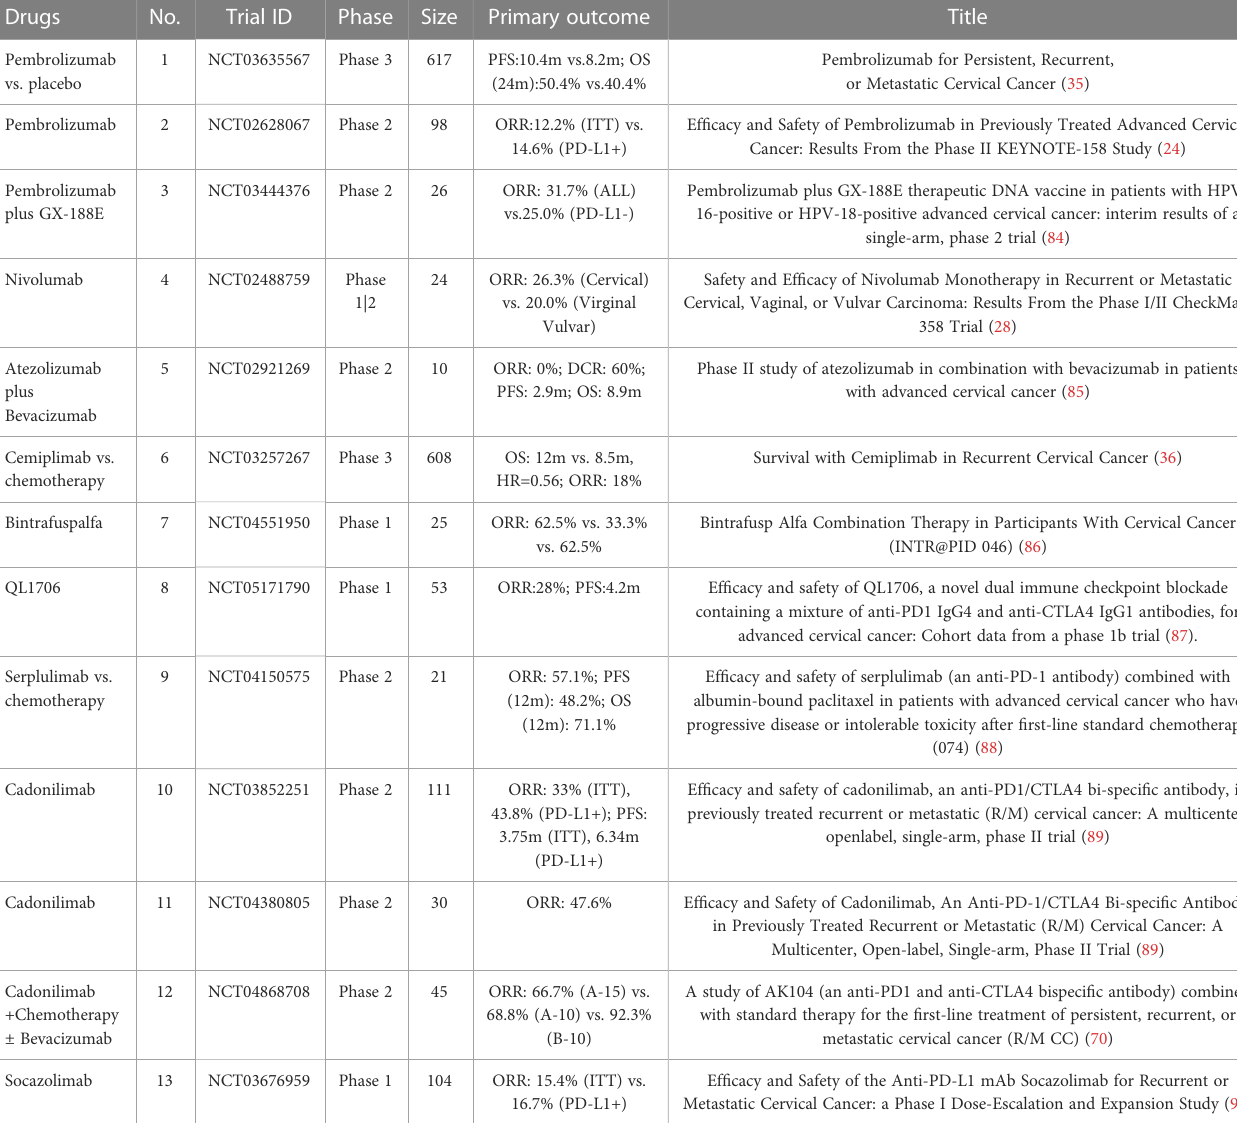
ITT, intend to treat; HR, hazard